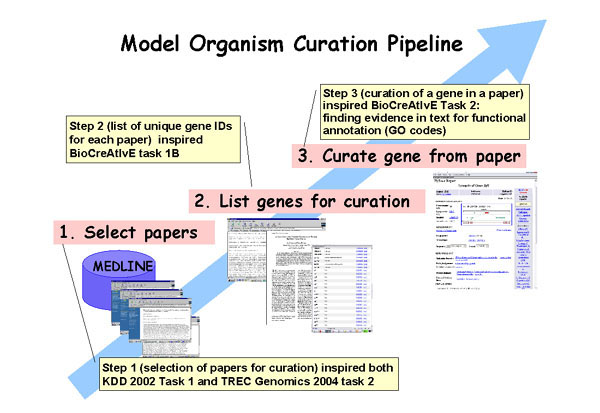
Curation pipeline for a model organism database.